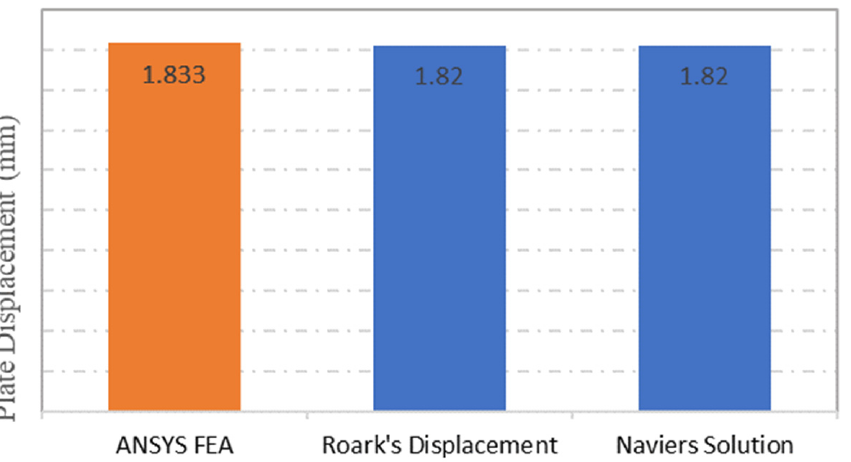
Figure 5. Plate maximum displacement comparison between ANSYS FEA, Roark’s Stress and Navier solution.